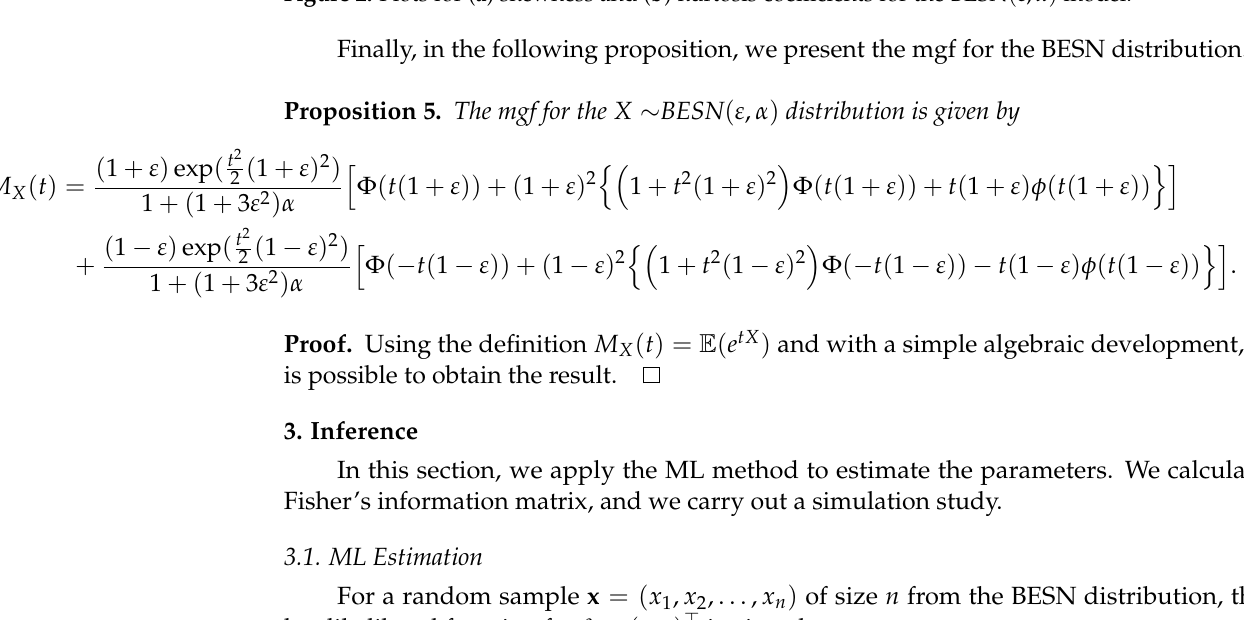
Figure 2. Plots for ( a ) skewness and ( b ) kurtosis coefficients for the BESN ( ε , α )